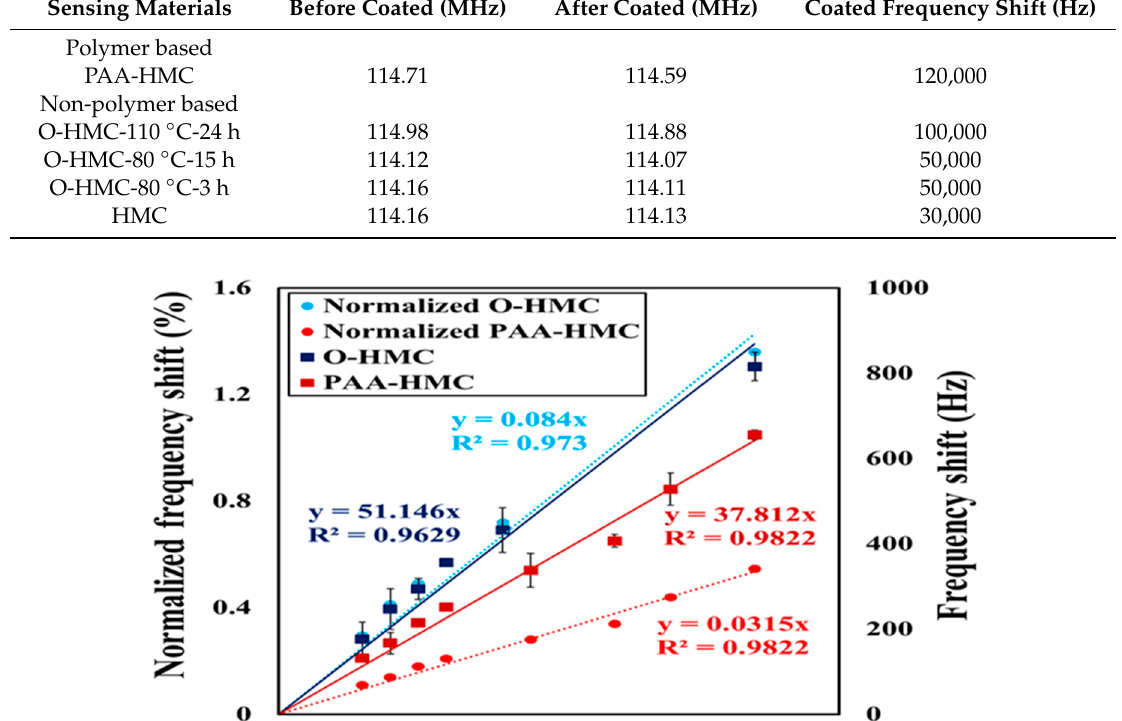
Table 1. Surface-acoustic-wave (SAW) Resonant frequency before and after coating.